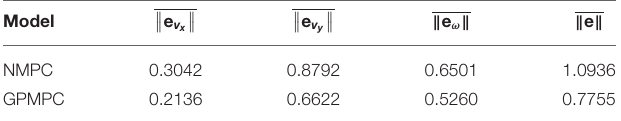
TABLE 5 | MSE comparison in right